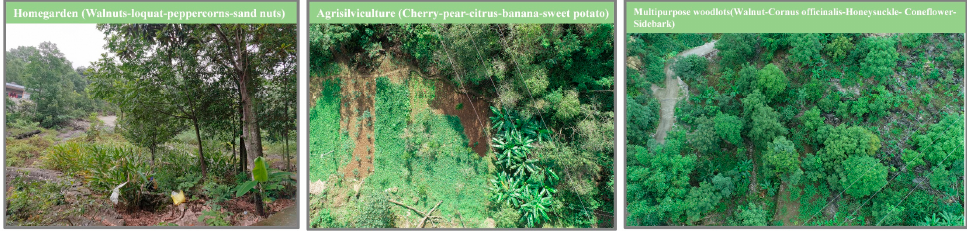
Figure 2. Schematic diagram of three types of AFS used in the control of KD in BJ. Second, the Guanling-Zhenfeng Huajiang Karst Plateau Canyon moderate intensity KD area was selected as the second study area (hereafter referred to as HJ) (25°39 ′ 20 ″ – 25°41 ′ 20 ″ N, 106°37 ′ 30 ″ –106°39 ′ 49 ″ E). There are various types of landforms and frag- mented terrain. The favorable and hostile landscape, such as peaks, depressions, funnels, dark rivers, and water caves, are widely developed in the area. The elevation ranges from 370 to 1473 m with a relative elevation di ff erence of 1103 m; the study area has a dry and hot southern subtropical valley climate, with warm and dry winters and springs and hot and humid summers and autumns, with an average annual temperature of about 18.4°C and an average yearly precipitation of about 1100 mm [41]. The soil is predominantly de- veloped on limestone with high soil fertility, but the soil layer is shallow and discontinu- ous, with poor water retention and drought tolerance [43]. The AFS in the KD area mainly comprises walnut, prickly pear, plum, apple, peach, loquat, and other fruit trees with ryegrass, white clover, and other forage grasses, corn, potatoes, beans, and other crops (Figure 3).